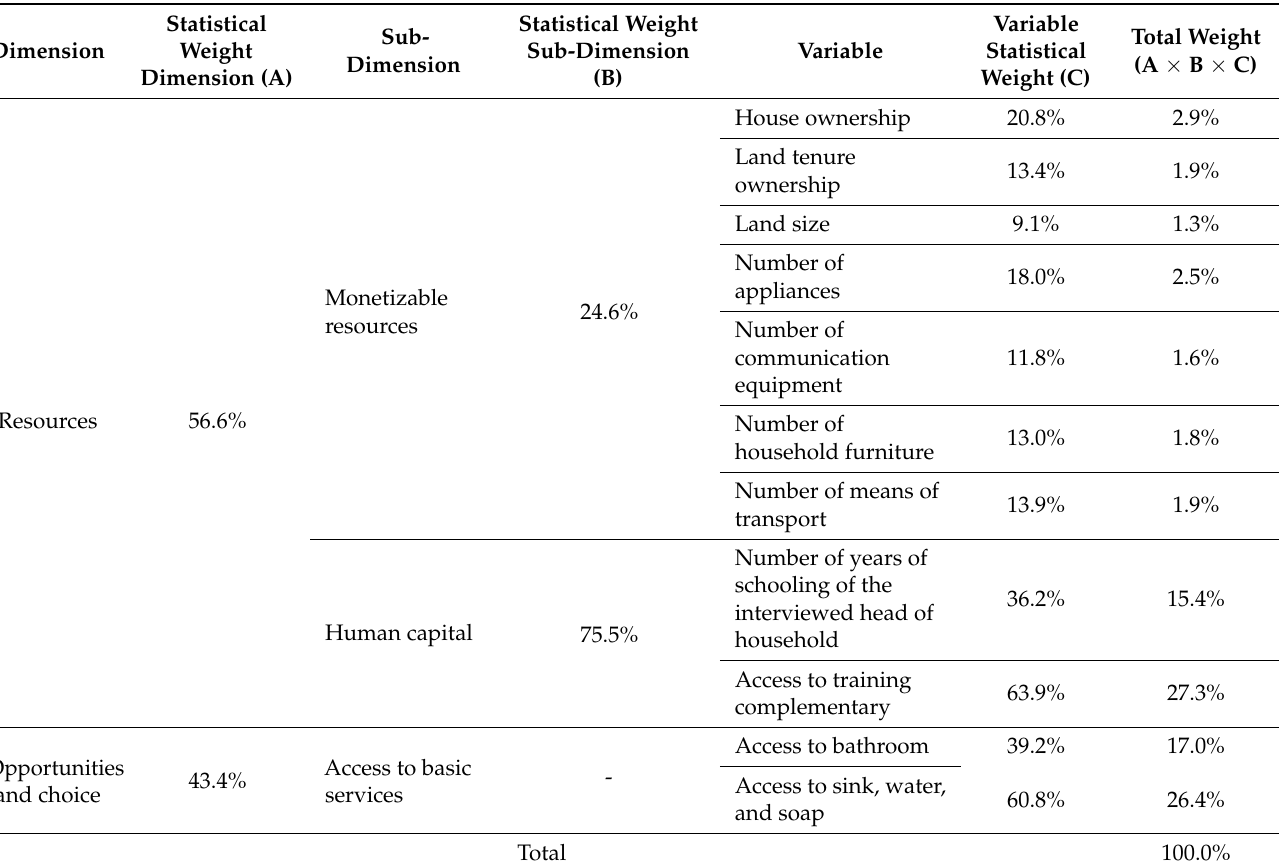
Table 6. Disaggregation of the Urban